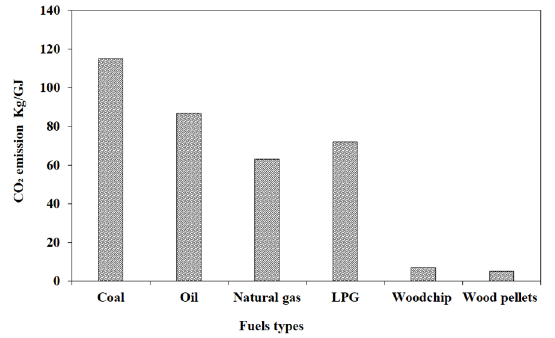
Fig. 8. CO 2 emissions from various fossil